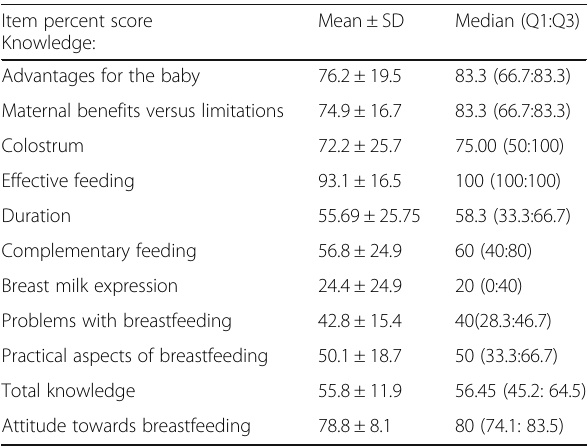
Table 2 Baseline percent scores of breastfeeding knowledge and attitude among interns ( n = 137) at Cairo University Hospital, Egypt, 2017 –